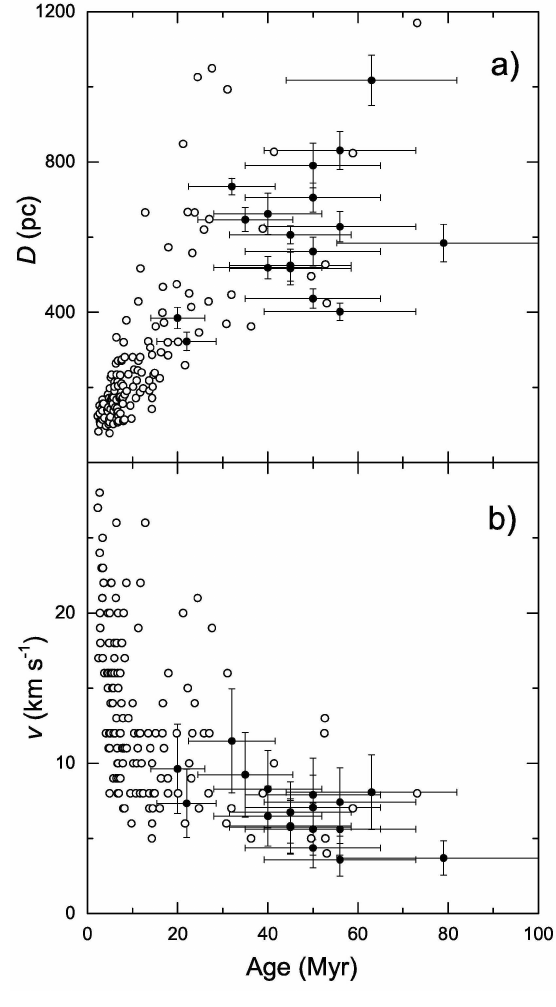
Fig. 3. Panels: a) the size vs. the age for the supershells identified in the studied field (filled circles) and for the H I holes (open circles) identified by Deul & den Hartog (1990) in the M 33 galaxy; b) the velocity of the propagating star formation in the identified supershells (filled circles) and the expansion velocity of the H I holes (Deul & den Hartog 1990) (open circles) vs. the age of a given